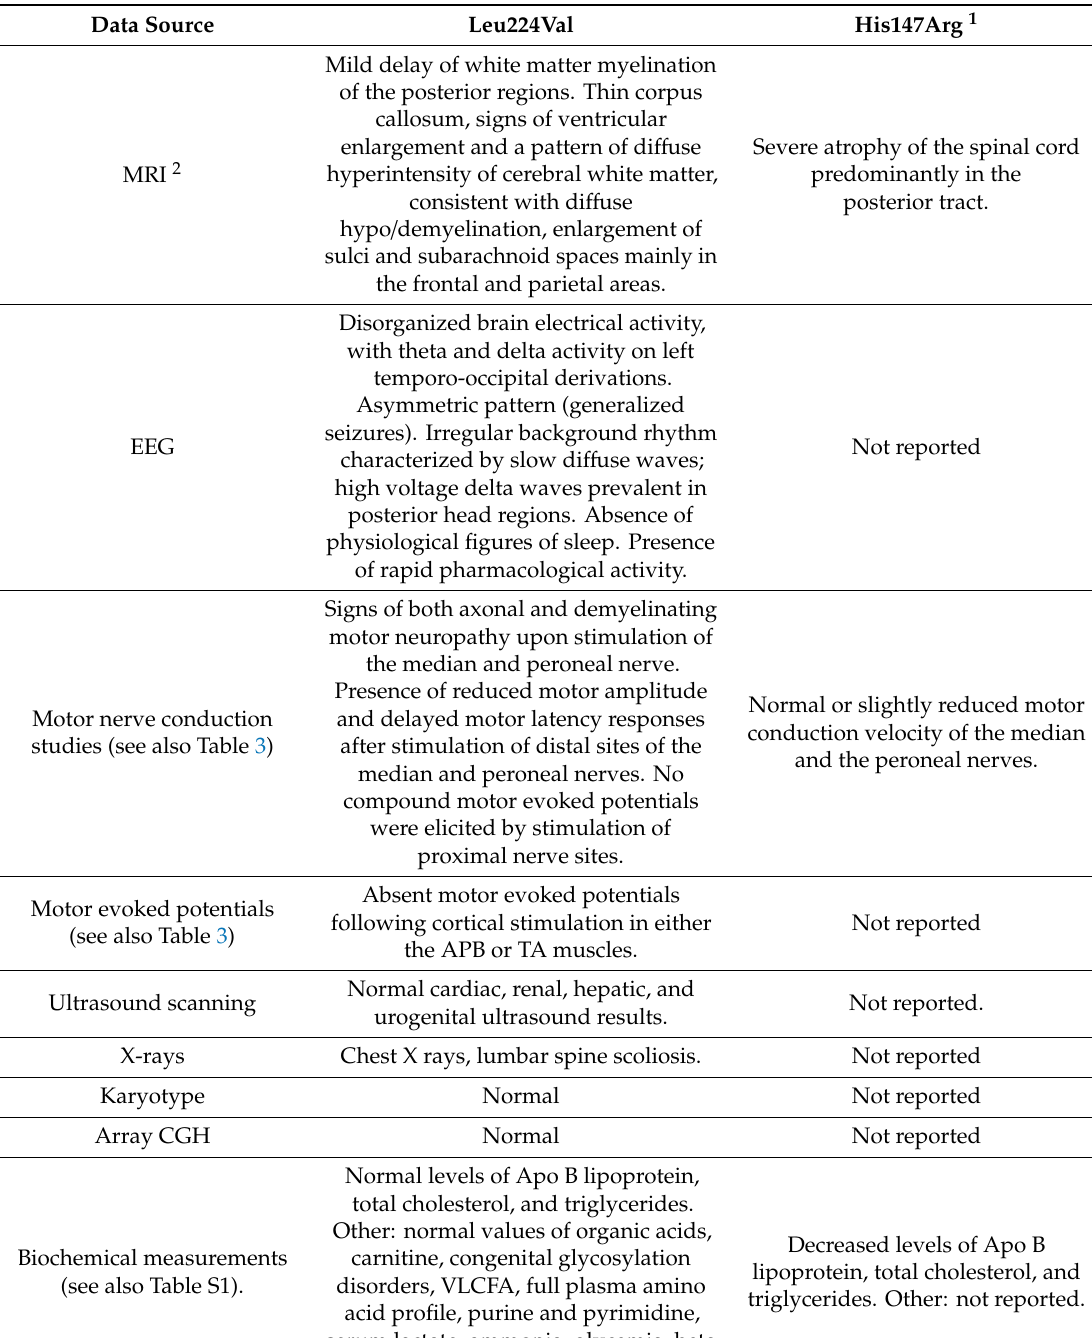
Table 2. Neurophysiological and laboratory data for both